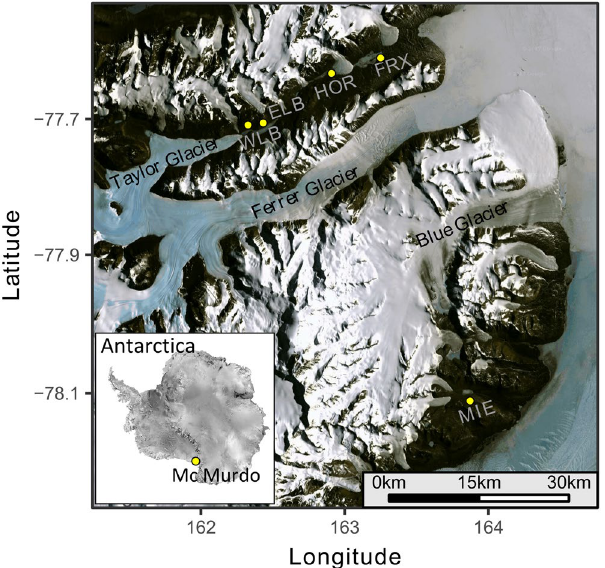
Figure 1. Geographical location of the five ice-covered lake basins studied in McMurdo Dry Valleys, Antarctica. This map was generated the R ggmap package 63 importing satellite images from Google imagery©2017 NASA. ELB: Lake Bonney East lobe, WLB: Lake Bonney West lobe, HOR: Lake Hoare, FRX: Lake Fryxell, MIE: Lake